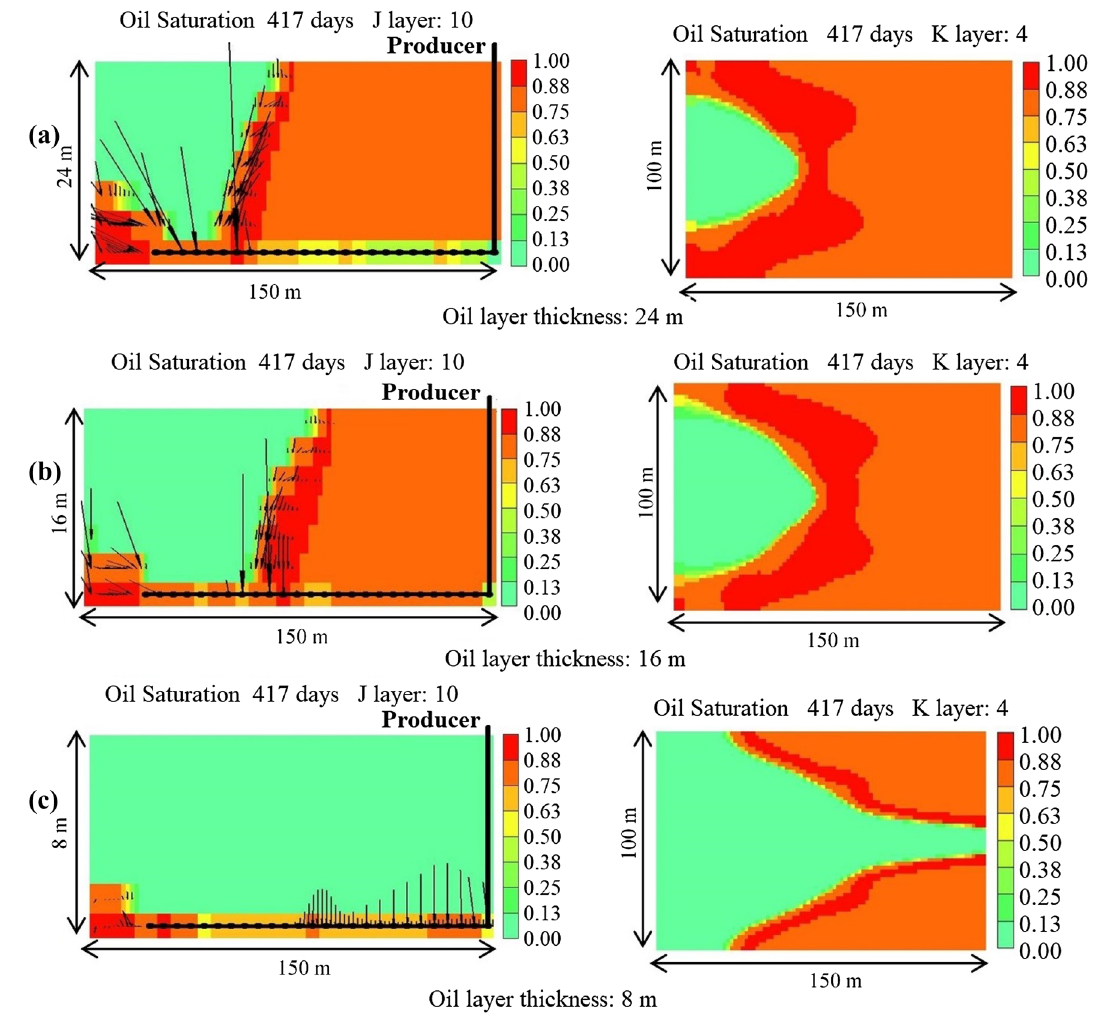
Fig. 5 Oil saturation profiles at 417 days: along the vertical mid-plane (left) and along the horizontal mid-plane (right) at constant air injection